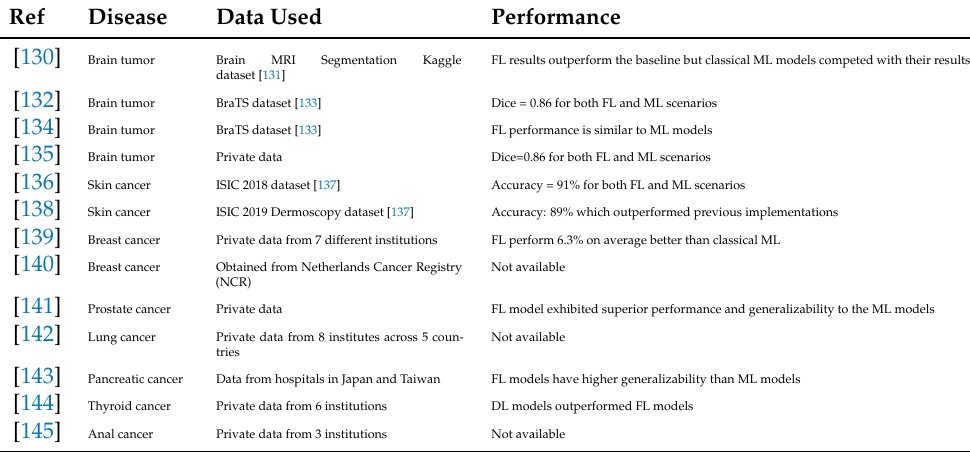
Table 6. Federated machine learning implementations in cancer